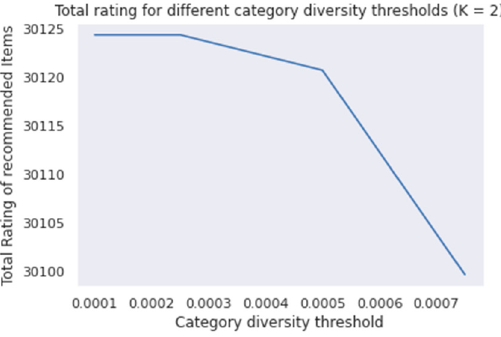
Figure 5. Total rating for different category Diversity thresholds for K = 2.